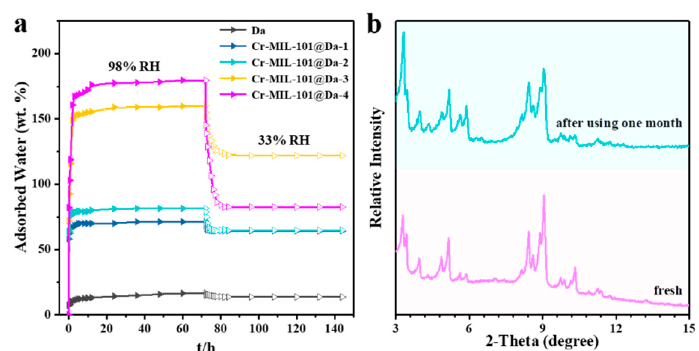
Figure 7. Water adsorptive performance and chemical stabilities. ( a ) water adsorption–desorption curve from relative humidity of 98% to 33% at 298 K, ( b ) comparison of XRD patterns between fresh and used Cr-MIL-101@Da-4 which was exposed with 98% RH–33% RH vapor pairs for over one month.